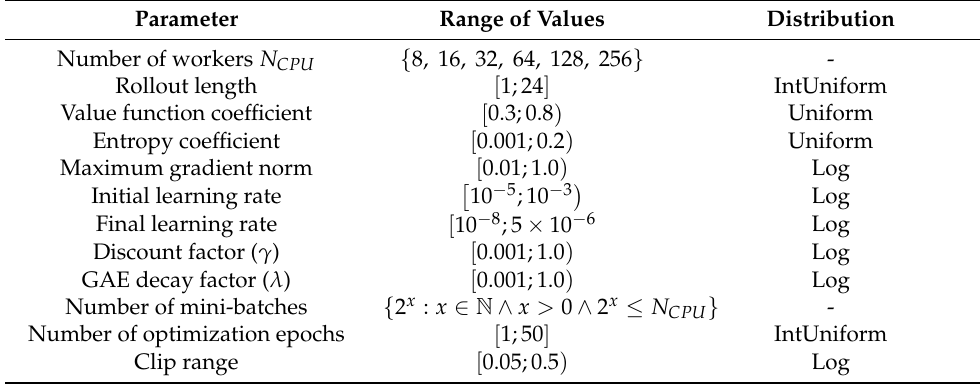
which values of each parameter are sampled. The IntUniform distribution generates integer values in the specified range with an equal probability assigned to each value. The Uniform distribution is the real-valued equivalent of this. The Log distribution uses the natural logarithm. Where the range of values is specified by a set, each value has equal probability of being selected. Table A1. All PPO algorithm hyper-parameters optimized in this work. Parameter